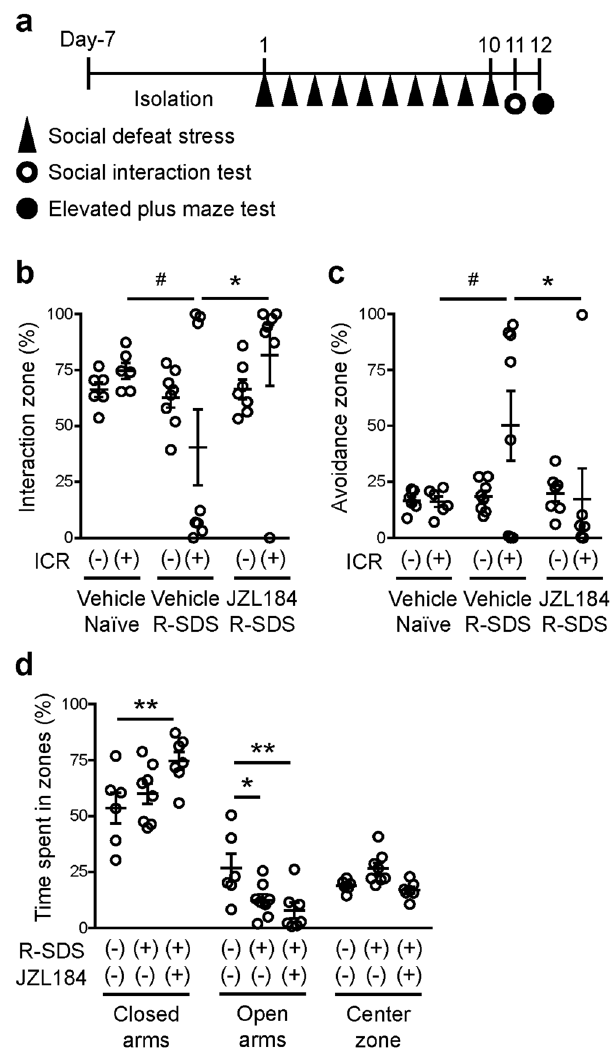
Figure 5. JZL184, an inhibitor for MAGL, suppresses social defeat stress-induced social avoidance. ( a ) Schedule of experiments. After social isolation for 1 week, a male wild-type mouse was subjected to SDS through an encounter with an ICR aggressor mouse for 10 min daily for 10 consecutive days (Day 1 through Day 10). JZL184 or vehicle was administered at 6 h before each SDS exposure. The social interaction test and the elevated anxiety test were performed after repeated SDS to analyze repeated SDS-induced social avoidance and elevated anxiety, respectively. ( b,c ) The effect of JZL184 on repeated SDS-induced social avoidance. The durations in the interaction ( b ) or avoidance ( c ) zone without or with an ICR mouse during the social interaction test were measured for wild-type mice without SDS (naïve) or with repeated SDS (R-SDS) which received i.p. injection of either vehicle or JZL184. ( d ) The effect of JZL184 on repeated SDS-induced elevated anxiety. The proportions of the time spent in the closed arms, open arms and center zone in the elevated plus maze test were measured for the same mice analyzed for the social interaction test. # P < 0.1, * P < 0.05, ** P < 0.01 for Bonferroni’s multiple comparison test. Data are shown as means ±